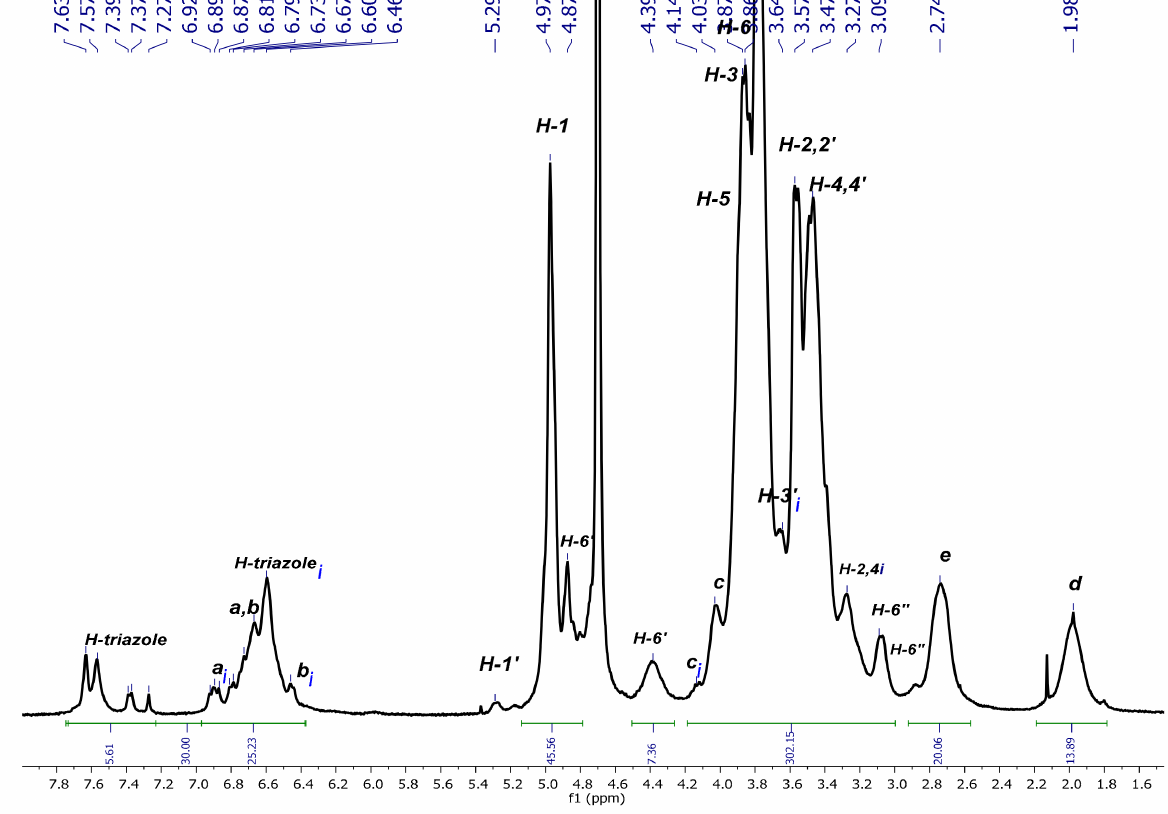
Figure 3. 1 H-NMR spectrum of P 3 N 3 -[O-C 6 H 4 -O-(CH 2 ) 3 - β CD] 6 ( I ) in D 2